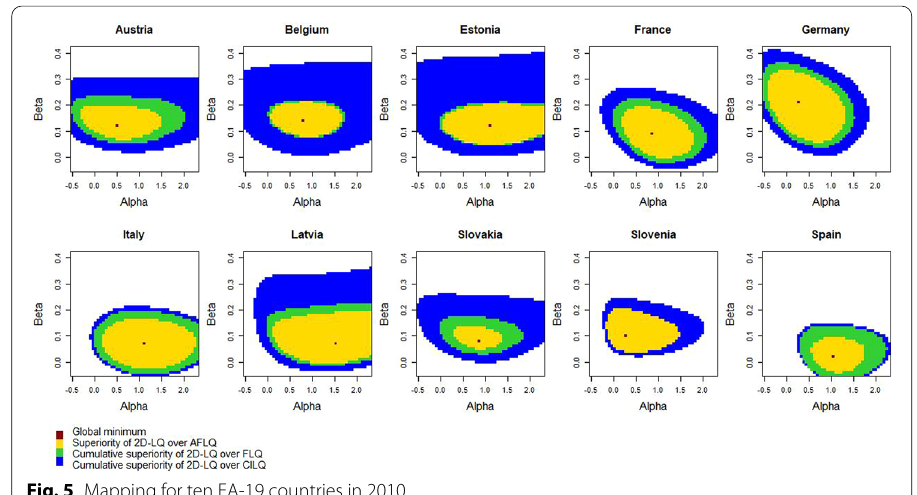
Fig. 5 Mapping for ten EA‑19 countries in